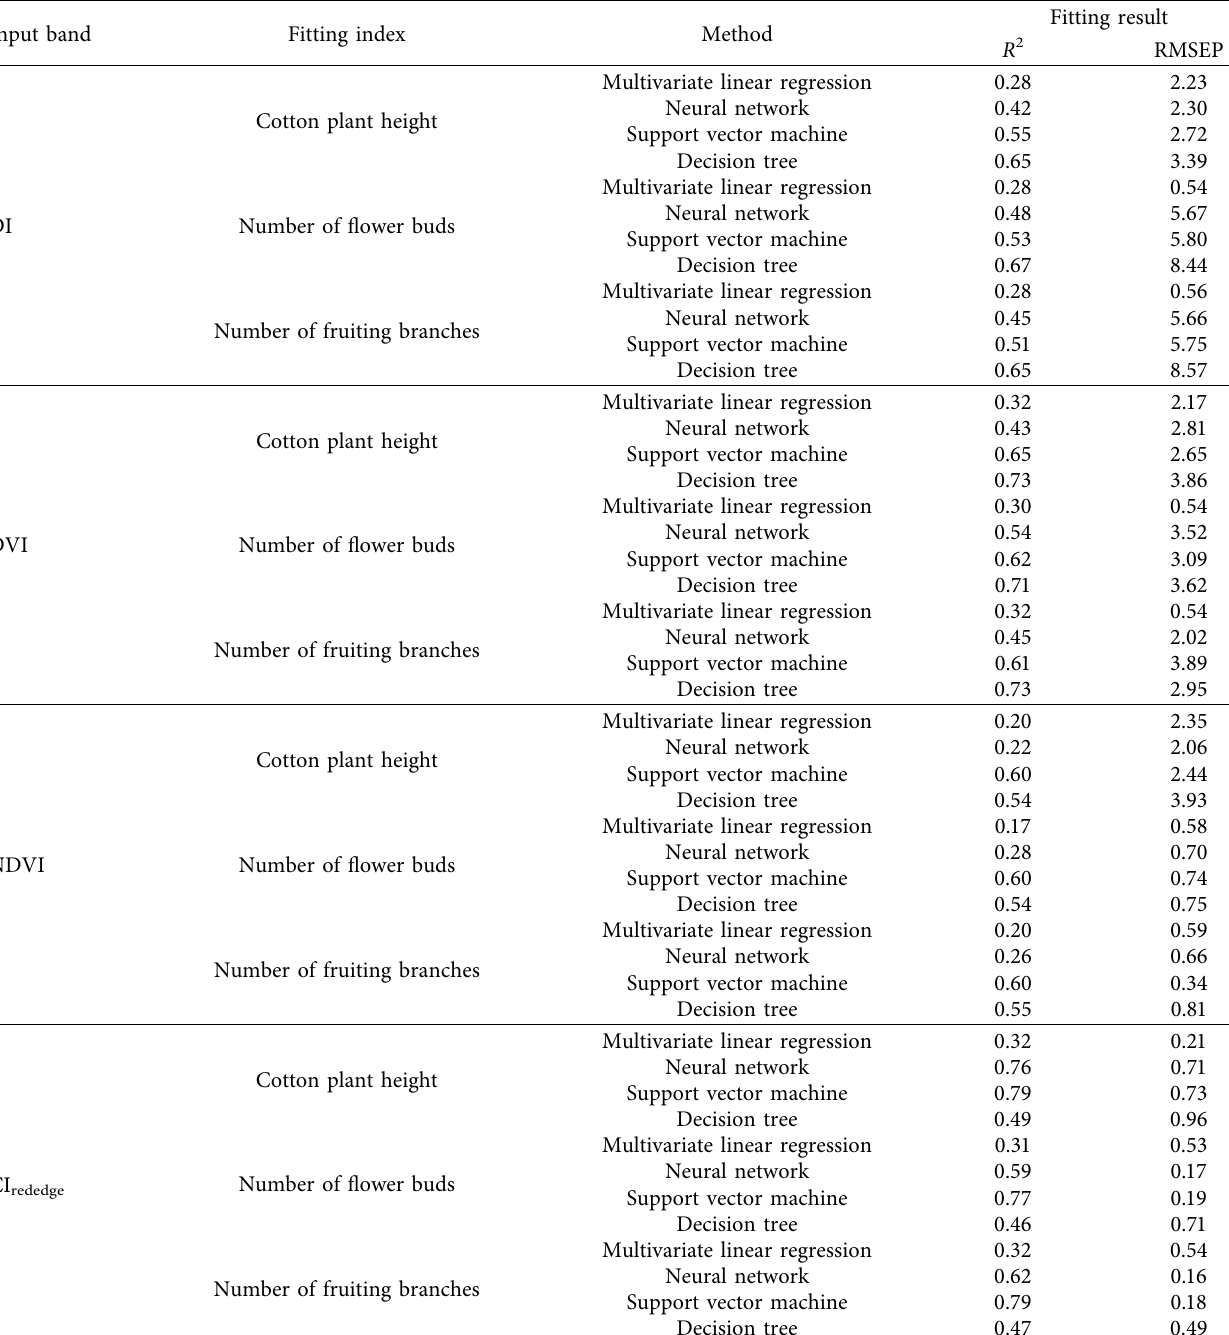
Table 2: Regression table of traditional vegetation index and the cotton plant height, flower buds, and fruiting branches. Input